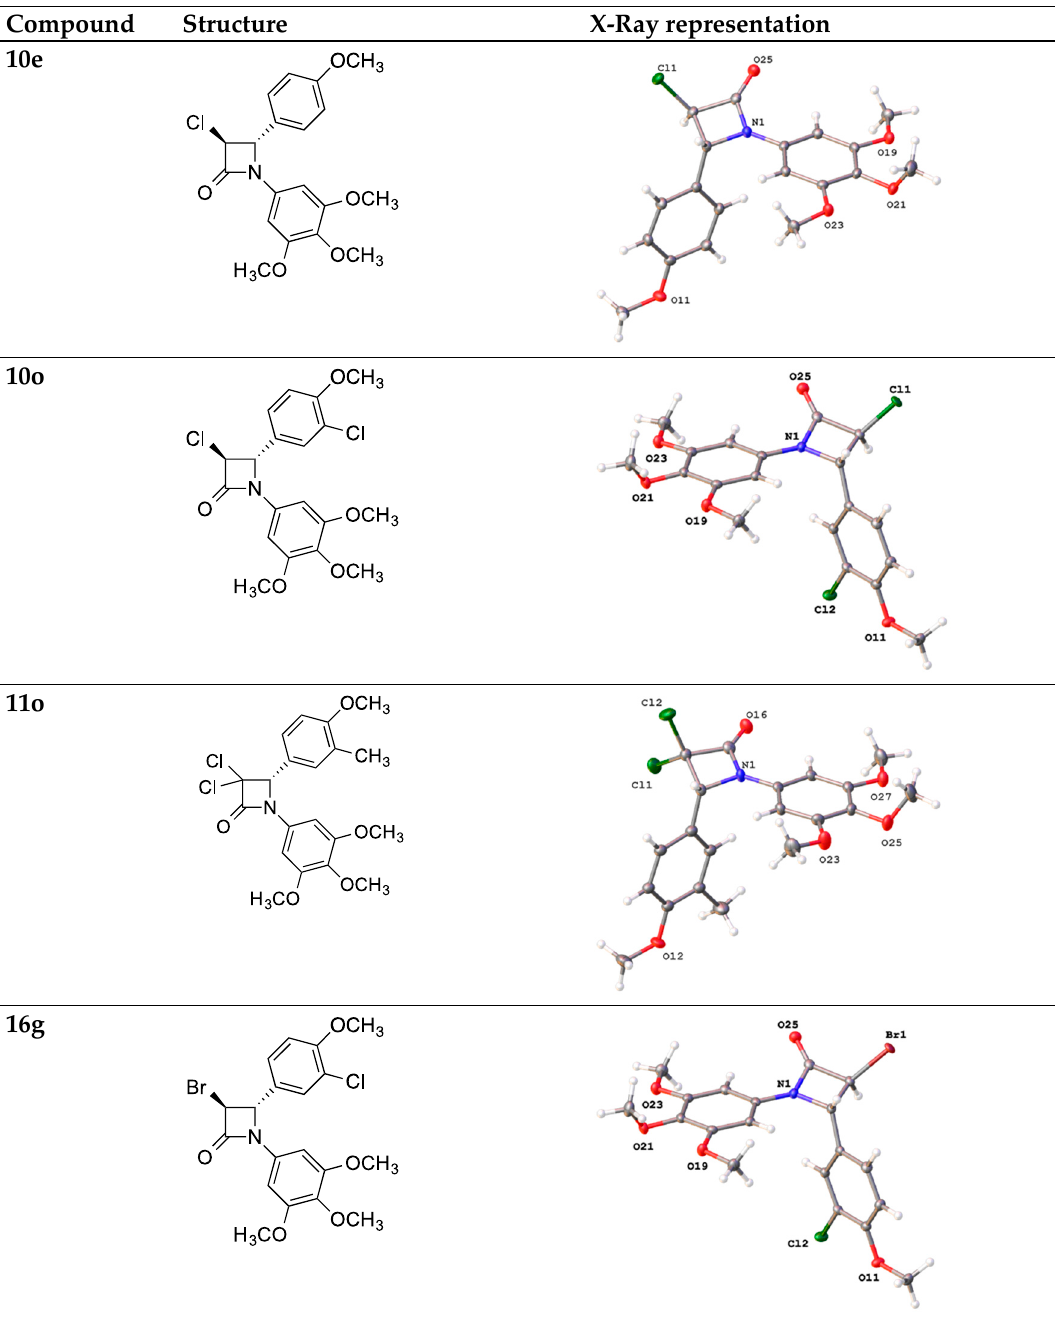
Figure 3. ORTEP representation of the X-ray crystal structure of compounds 10e , 10o , 11o and 16g with heteroatoms labelled and thermal ellipsoids set at 50% probability. Structure 11o shows the majority occupied disordered 4-methoxyphenyl moiety (81% occupied). For structures 10o and 16g , the 3 position is substituted by both chloride (75%) and bromide (25%); distances restrained, and atomic displacement constrained.